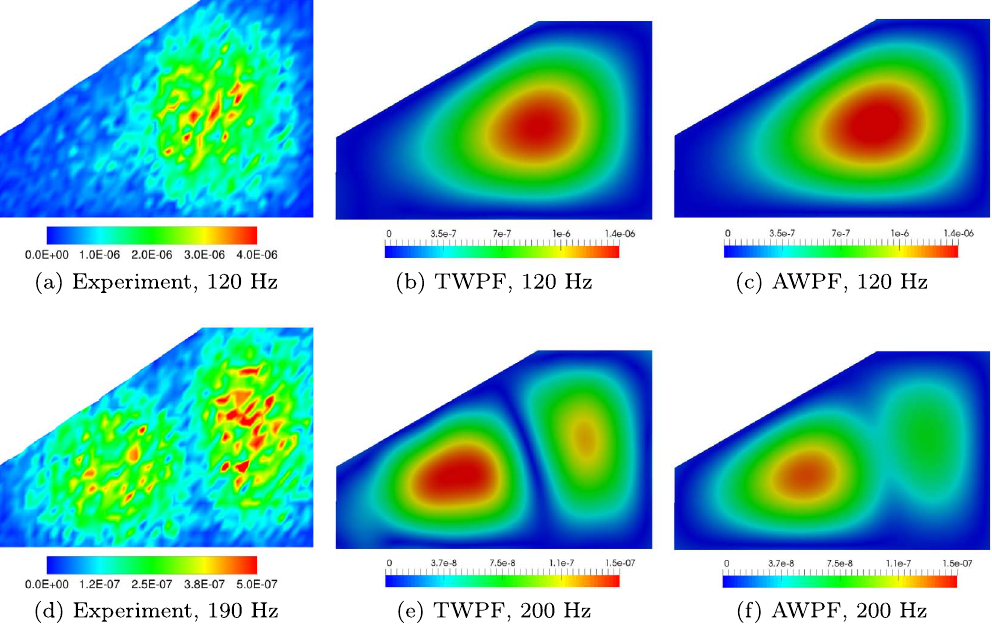
Figure 11. Comparison of displacement of side window in m from vibrometer measurements (150 km/h) [15] and simulation (100 km/h) with aerodynamic and acoustic pressure excitation.